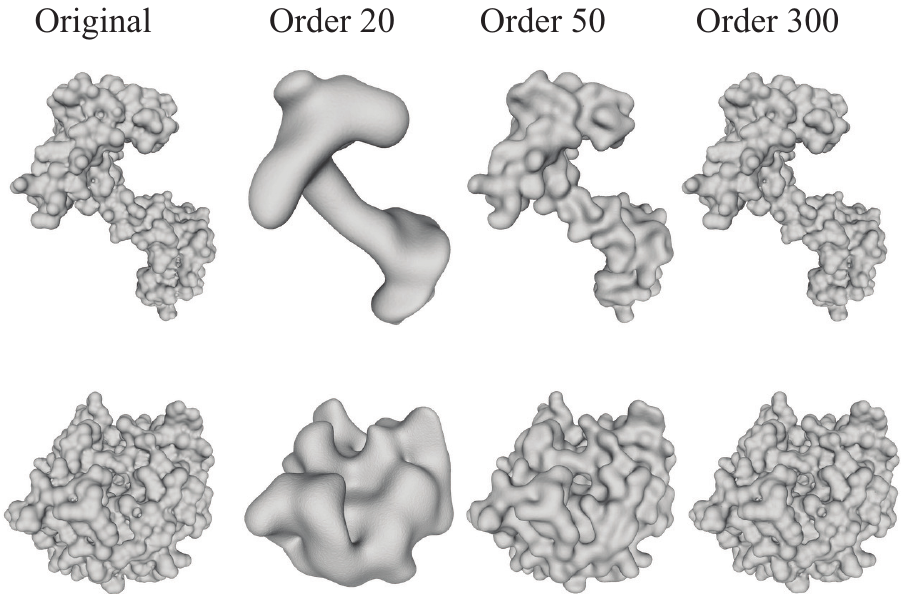
Figure 10. Reconstruction of Calmodulin ( top row ), and TIM ( bottom row ) from the Zernike mo- ments computed from a triangle mesh representing their boundaries. Calmodulin (PDB code 1CLL) is a human small calcium binding protein while TIM (PDB code 1TIM) is the chicken triose phosphate isomerase. Both proteins are represented as a union of balls, with each ball corresponding to an atom. The surface of this union of balls, triangulated with the program smesh [65,66], serves as input to the computation of the Zernike moments of their shapes. We compare the reconstructions generated from three different maximum order N , N = 20, N = 50, and N = 300. The original shape is shown on the left. All figures were generated with MeshLab